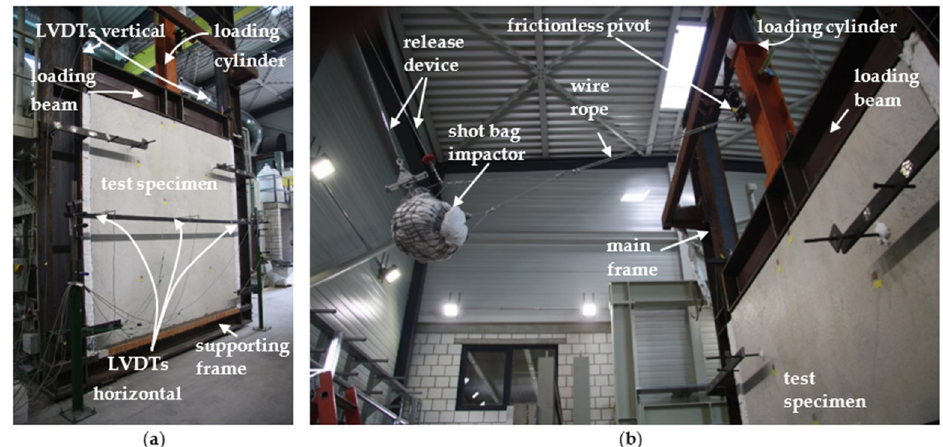
Figure 4. ( a ) Experimental set-up for fire tests under vertical eccentric loading. ( b ) Test set-up for the impact load in starting position—as in Test 2.